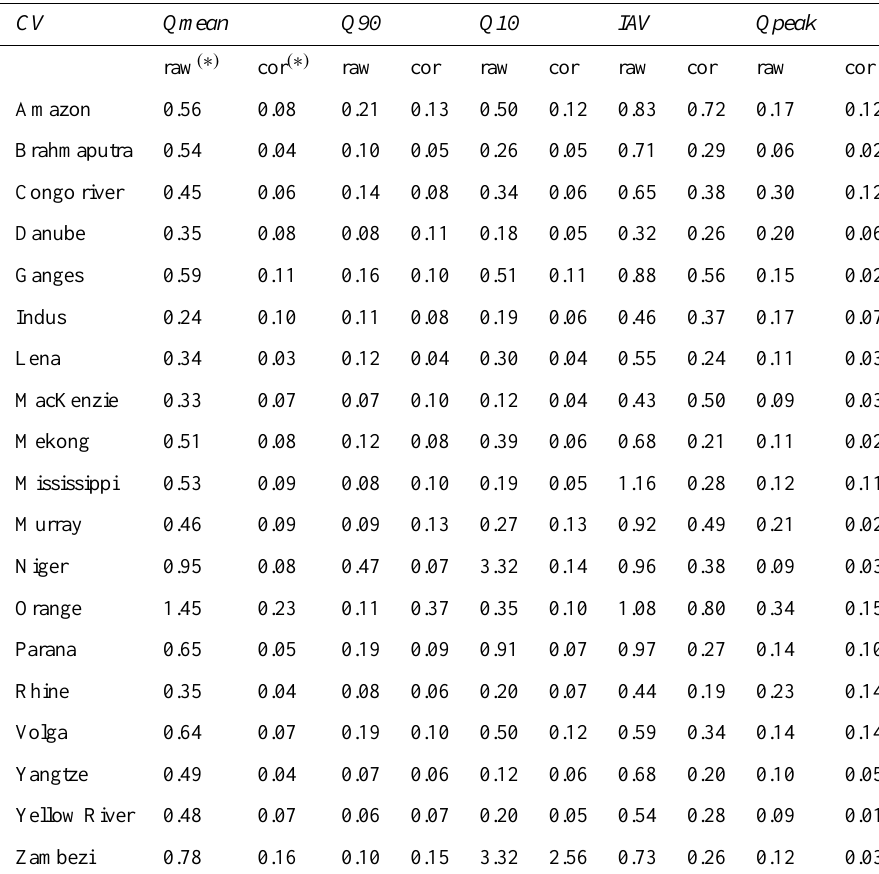
Table 5. Ensemble coefficients of variation of the GCM results for the statistics of interest.